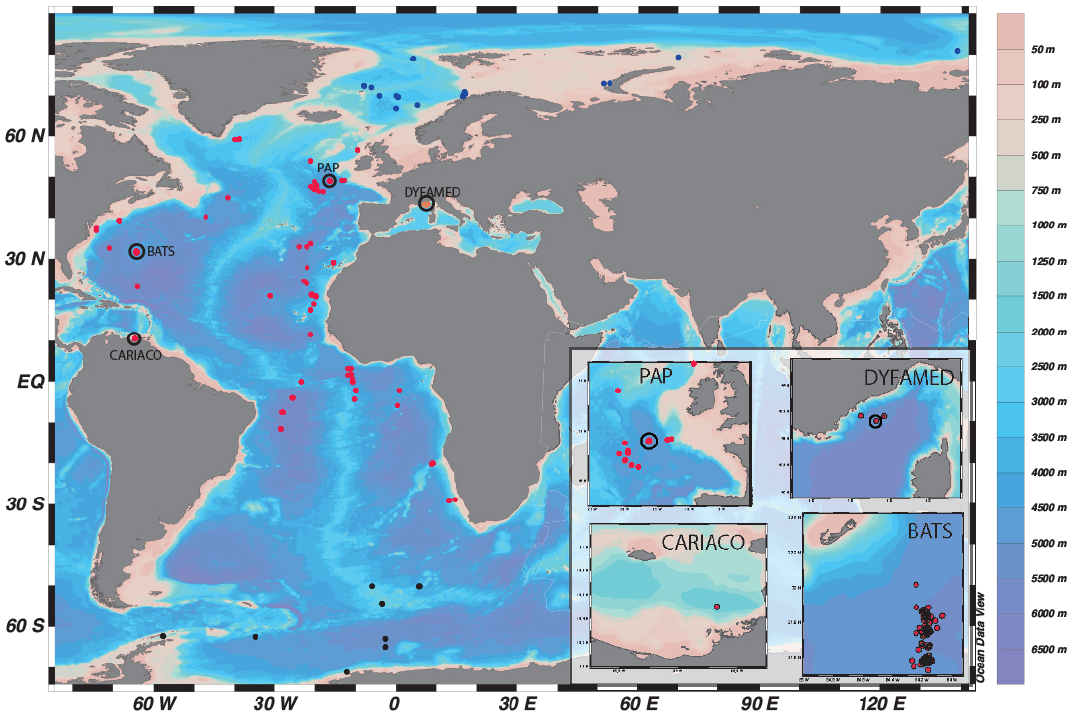
Figure 1. Map showing the location of sediment-trap deployments. Inset figures show expanded maps of regions where the CARIACO, BATS, PAP and DYFAMED time series are located. Locations are colour-coded per ocean domain: Atlantic (red dots), Mediterranean (orange dots), Arctic (blue dots), and Southern Ocean (black